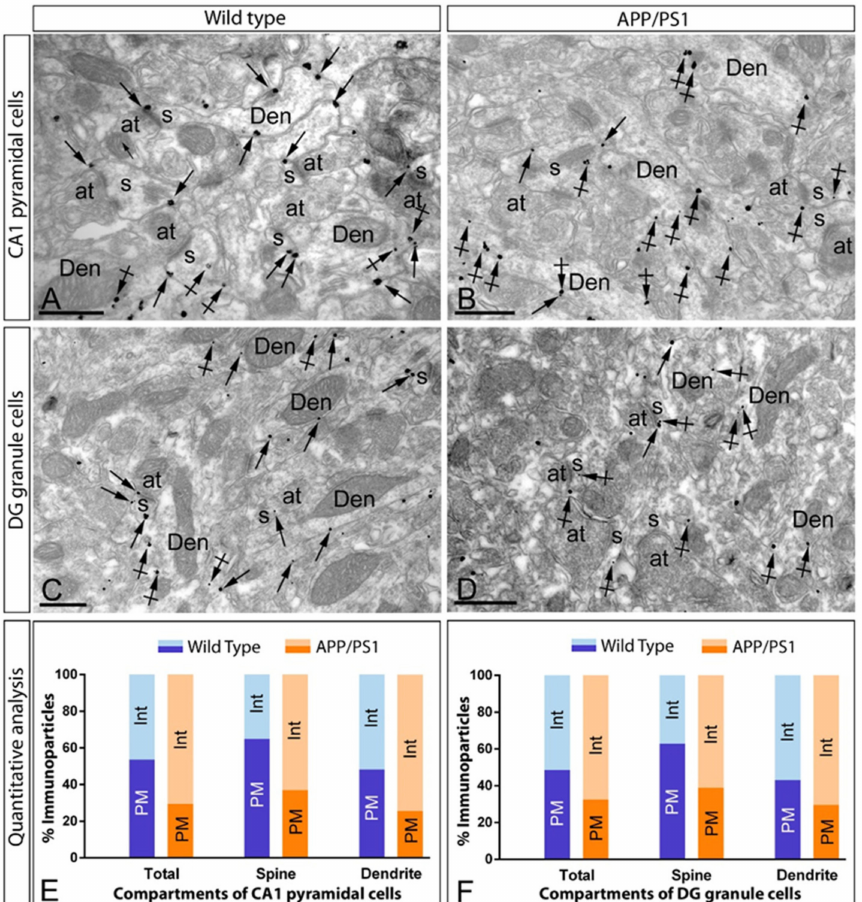
Figure 5. Intracellular distribution of mGlu 5 is increased in principal cells of APP/PS1 mice. Electron micrographs showing immunoparticles for mGlu 5 in the stratum radiatum of the CA1 region and molecular layer of the DG at 12 months of age in wild type and APP/PS1 mice, as detected using a pre-embedding immunogold technique. ( A – D ) In wild type mice, mGlu 5 immunoparticles were mostly located at the extrasynaptic membrane (arrows) of dendritic shafts (Den) and dendritic spines (s) of pyramidal and granule cells, and less frequently at intracellular sites (arrowheads). In APP/PS1 mice, however, fewer mGlu 5 immunoparticles were observed along the extrasynaptic membrane (arrows) of dendritic shafts (Den) and dendritic spines (s), while more immunoparticles were observed at intracellular sites (arrowheads). ( E , F ) Quantitative analysis at 12 months of age demonstrating that mGlu 5 immunoparticles were less frequently observed along the extrasynaptic plasma membrane of dendrites and spines of CA1 pyramidal cells and DG granule cells, and more frequently at intracellular sites in APP/PS1 mice. Scale bars: ( A – D ), 1 µ